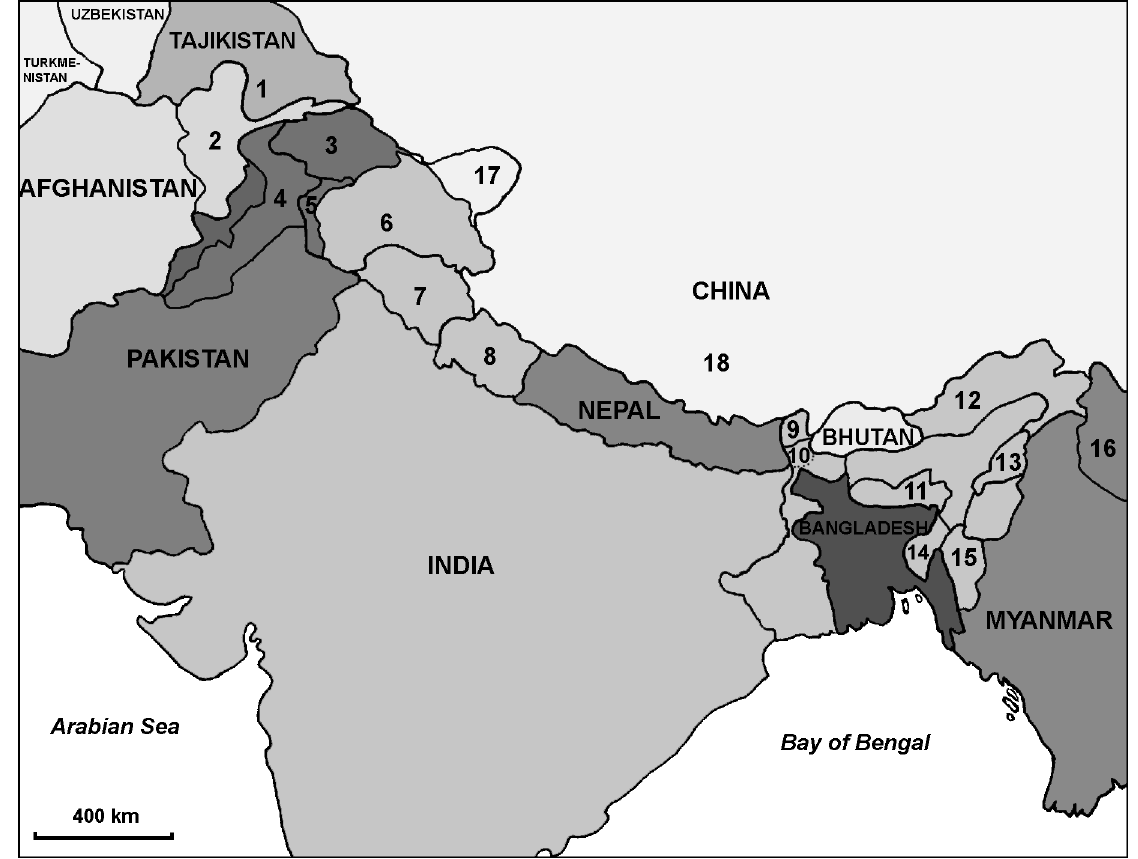
Fig. 1. Geographic map of the Himalayas and surrounding territories. 1 = Gorno-Badakhshan Province (Tajikistan); 2 = Badakhshan Province (Afghanistan); 3 = Gilgit-Baltistan; 4 = Khyber Pakhtunkhwa; 5 = Azad Jammu and Kashmir (Pakistan); 6 = Jammu and Kashmir; 7 = Himachal Pradesh; 8 = Uttarakhand; 9 = Sikkim; 10 = Darjeeling district of West Bengal; 11 = Meghalaya; 12 = Arunachal Pradesh; 13 = Nagaland; 14 = Tripura; 15 = Mizoram (India); 16 = Kachin State (Myanmar); 17 = Aksai Chin; 18 = Xizang